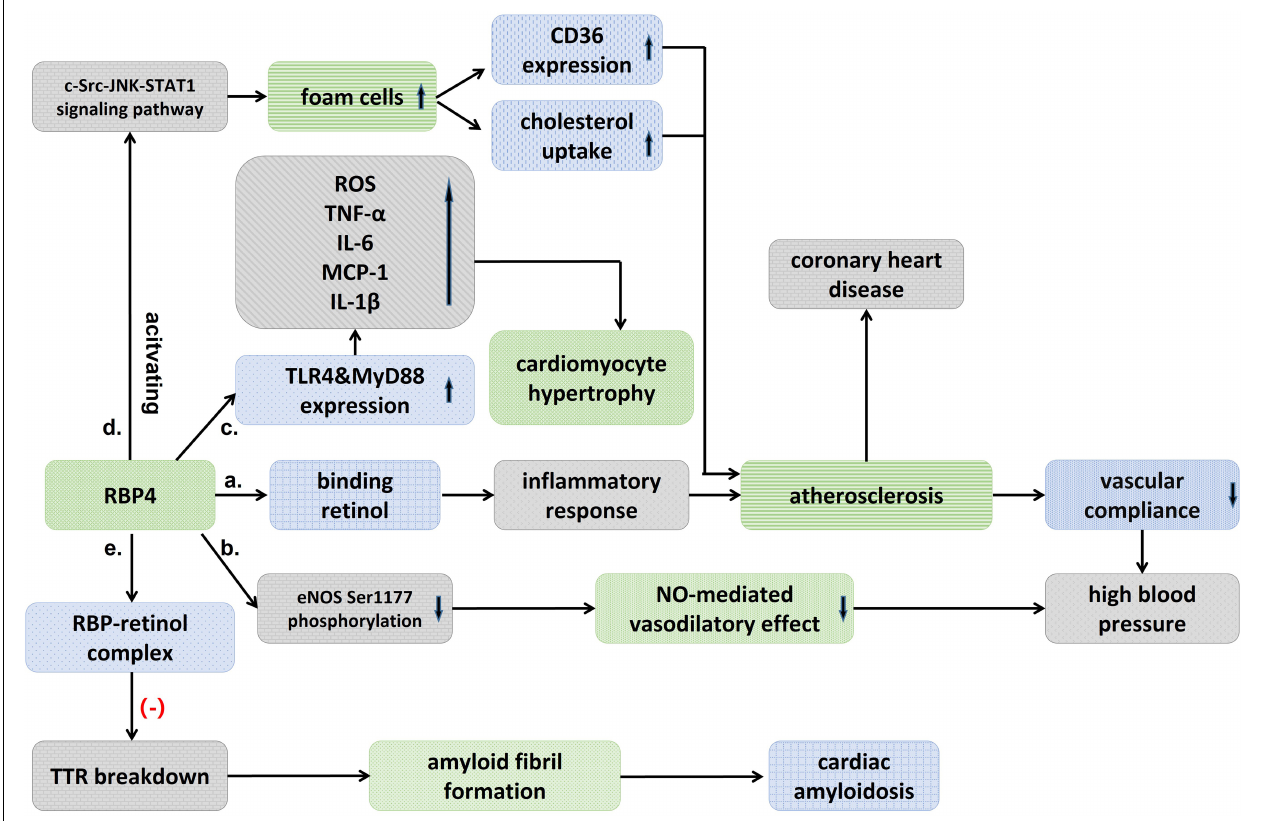
FIGURE 1 | Schematic diagram showing an association between RBP4 and cardiovascular diseases. (a) Binding to retinol, RBP4 activates an inflammatory response that induces atherosclerosis and decreased vascular compliance, and thus raises blood pressure. (b) RBP4 could also result in high blood pressure by attenuating eNOS Ser1177 phosphorylation and then the nitric-oxide (NO)-mediated vasodilatory effect. (c) RBP4 stimulates TLR4 and MyD88 experssion, which significantly promotes the pro-inflammatory response and increases ROS, and then cause cardiomyocyte hypertrophy. (d) RBP4 promotes the formation of foam cells, which upregulates CD36 expression and cholesterol uptake, and atherosclerosis, thereby leading to coronary heart disease. (e) RBP-retinol complex could reduce TTR breakdown and then inhibit the formation of amyloid fibril and avoid cardiac